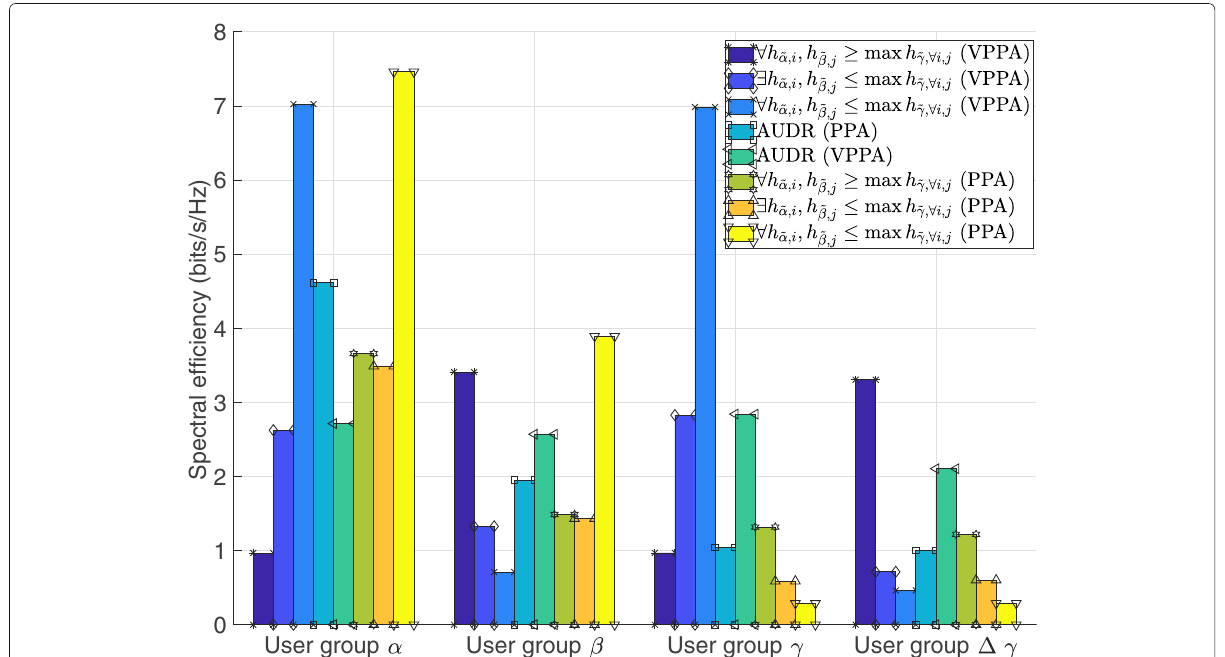
Fig. 6 Spectral efficiency of each user group with (cid:5) 1 / 2 = 60